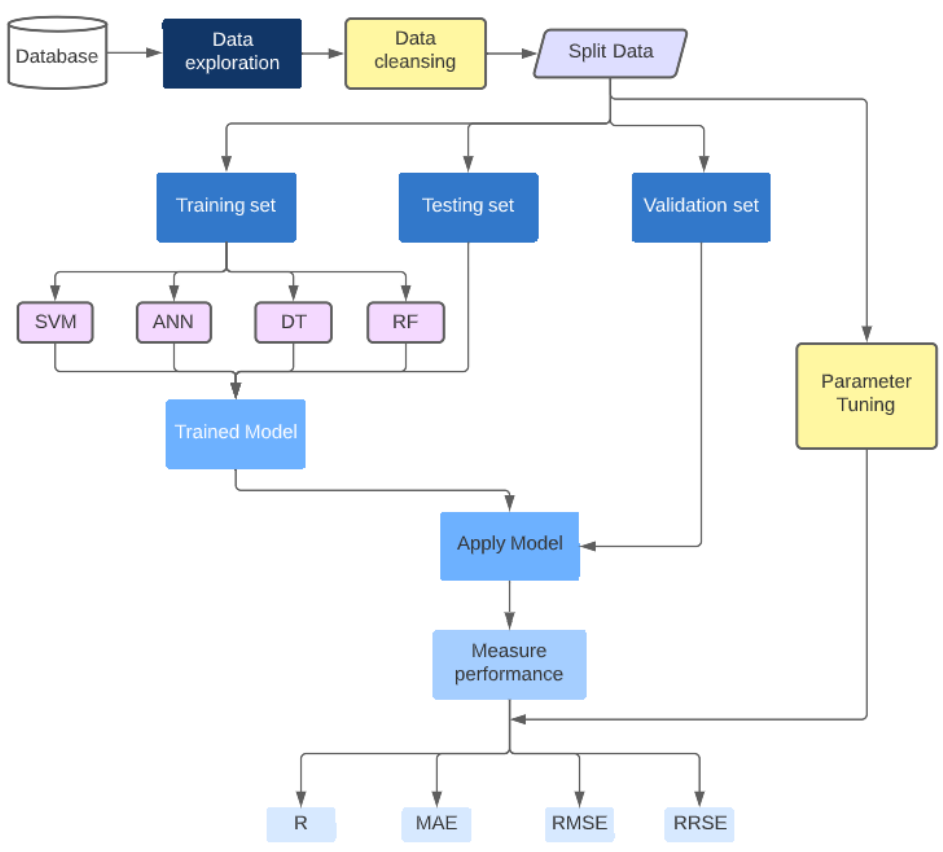
Figure 1. Flowchart of the followed methodology .